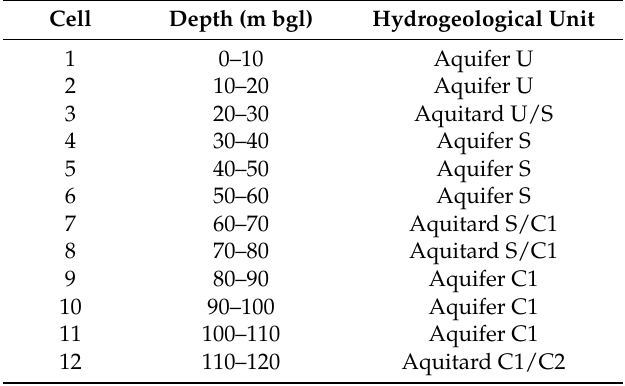
Table 1. Model geometry and corresponding hydrogeological units.